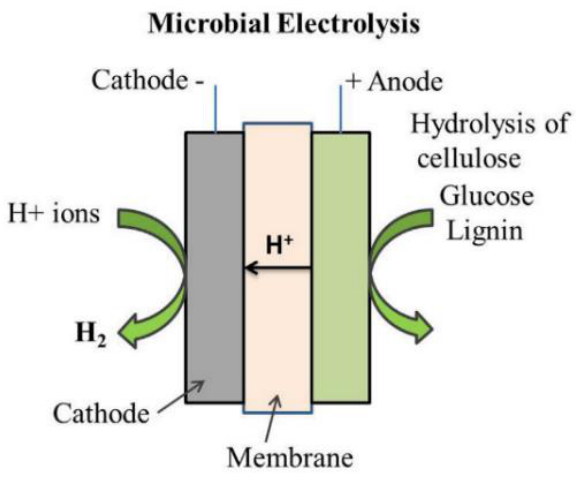
Figure 10. Microbial electrolysis. Reproduced with permission from [19].